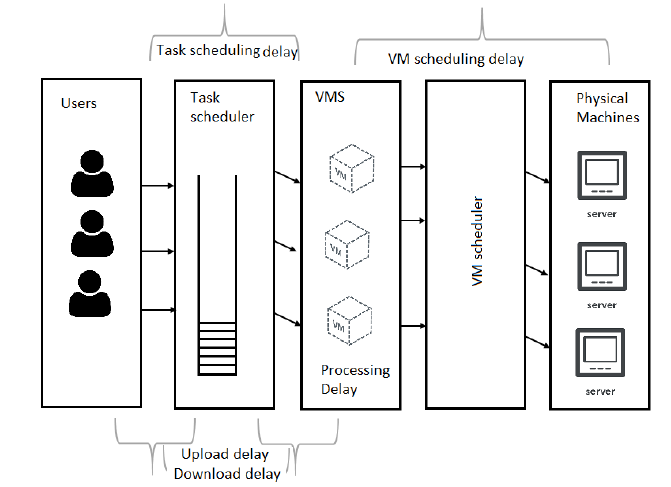
Figure 1. Delay types in multi-access edge